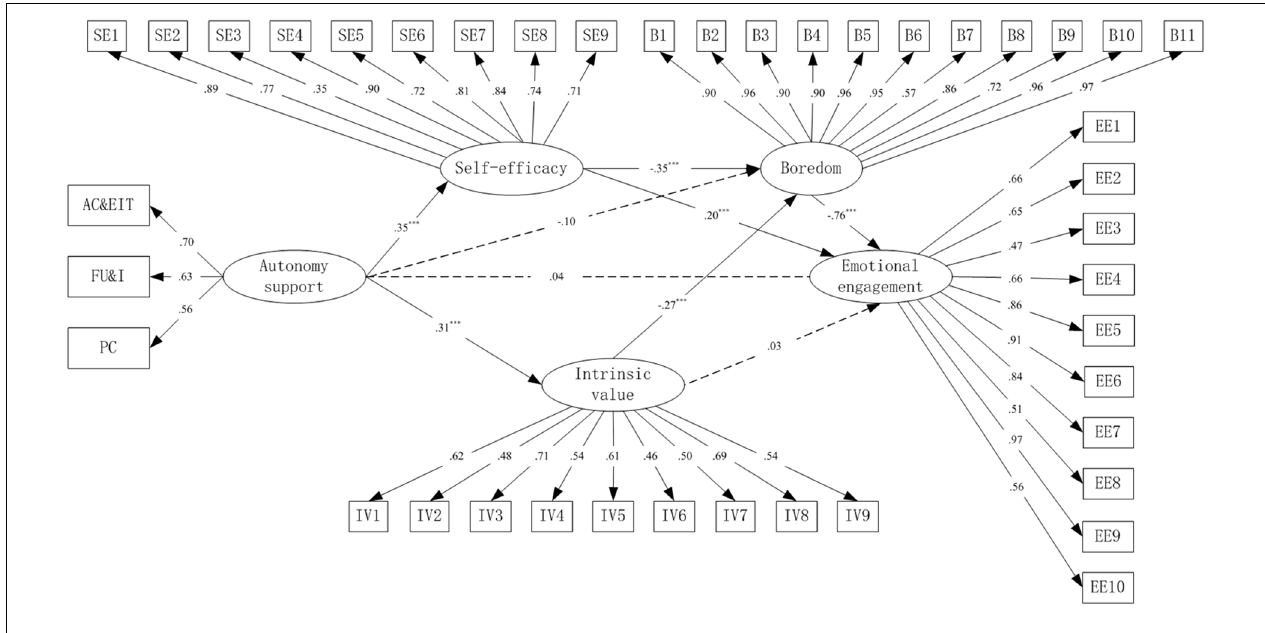
FIGURE 3 | Full mediation model for emotional engagement as dependent variable. PC, providing choice; FU&I, fostering understanding and interest; AC&E IT, allowing criticism and encouraging independent thinking; SE1–SE9, nine items of self-efficacy; IV1–IV9, nine items of intrinsic value; B1–B11, 11 items of boredom; EE1–EE10, 10 items of emotional engagement. ∗∗∗ p < 0.001.